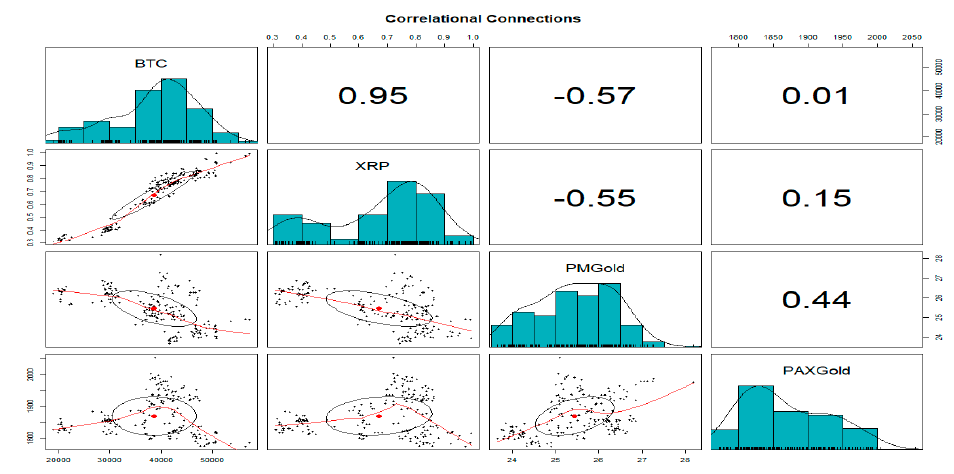
Figure 2. Binary relation scatter plot.